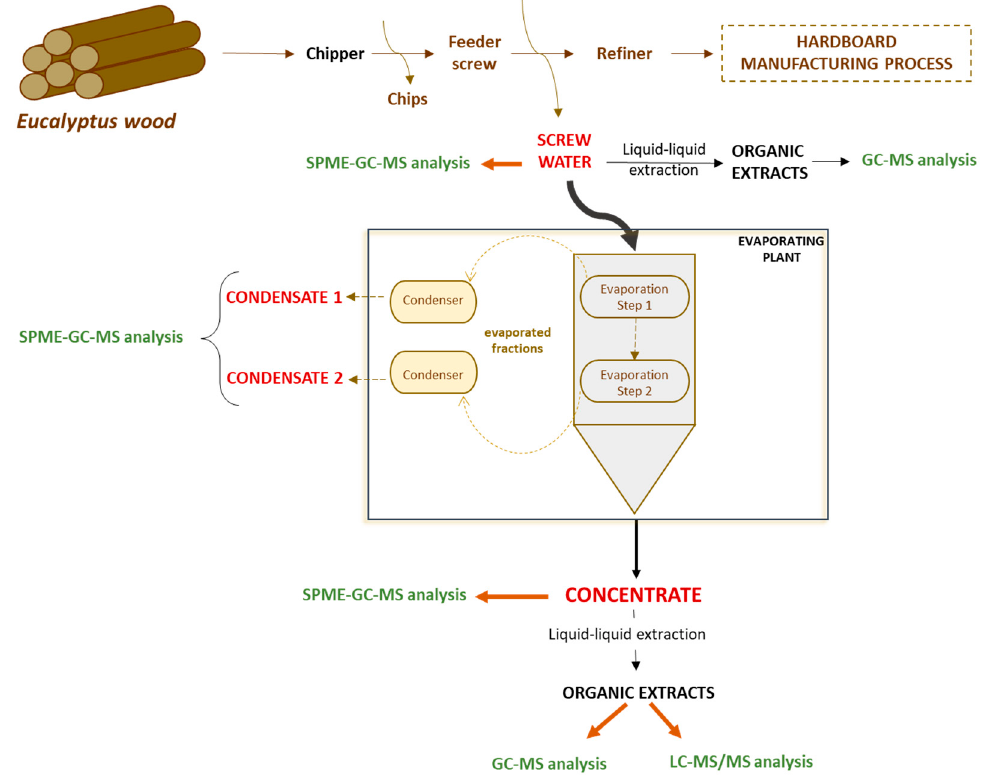
Figure 1. Outline of the Eucalyptus greenboard production process showing the generated by-products, their derived organic extracts and the chromatographic strategies used for their characterization.